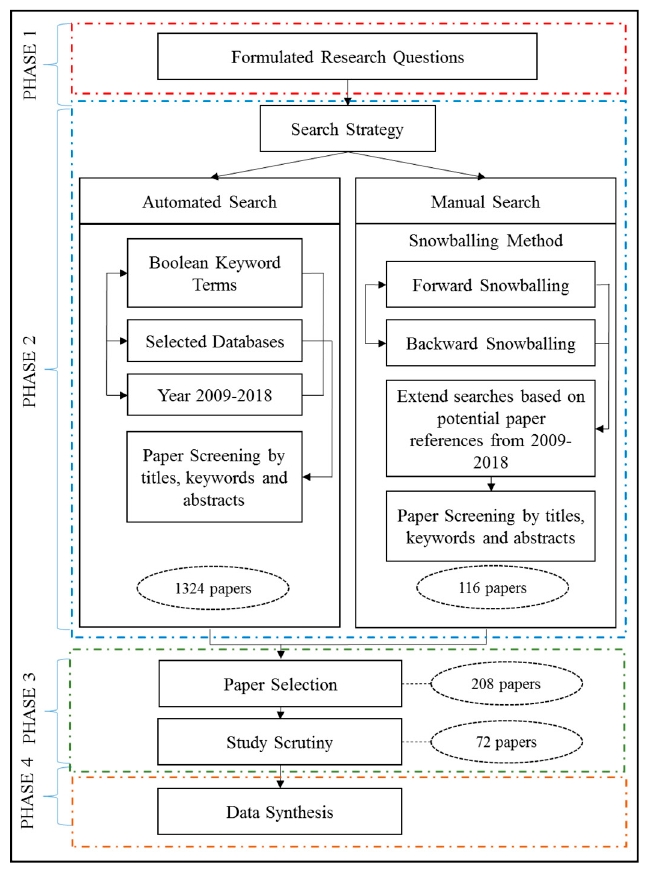
Figure 1. Research method. Table 1. List of research